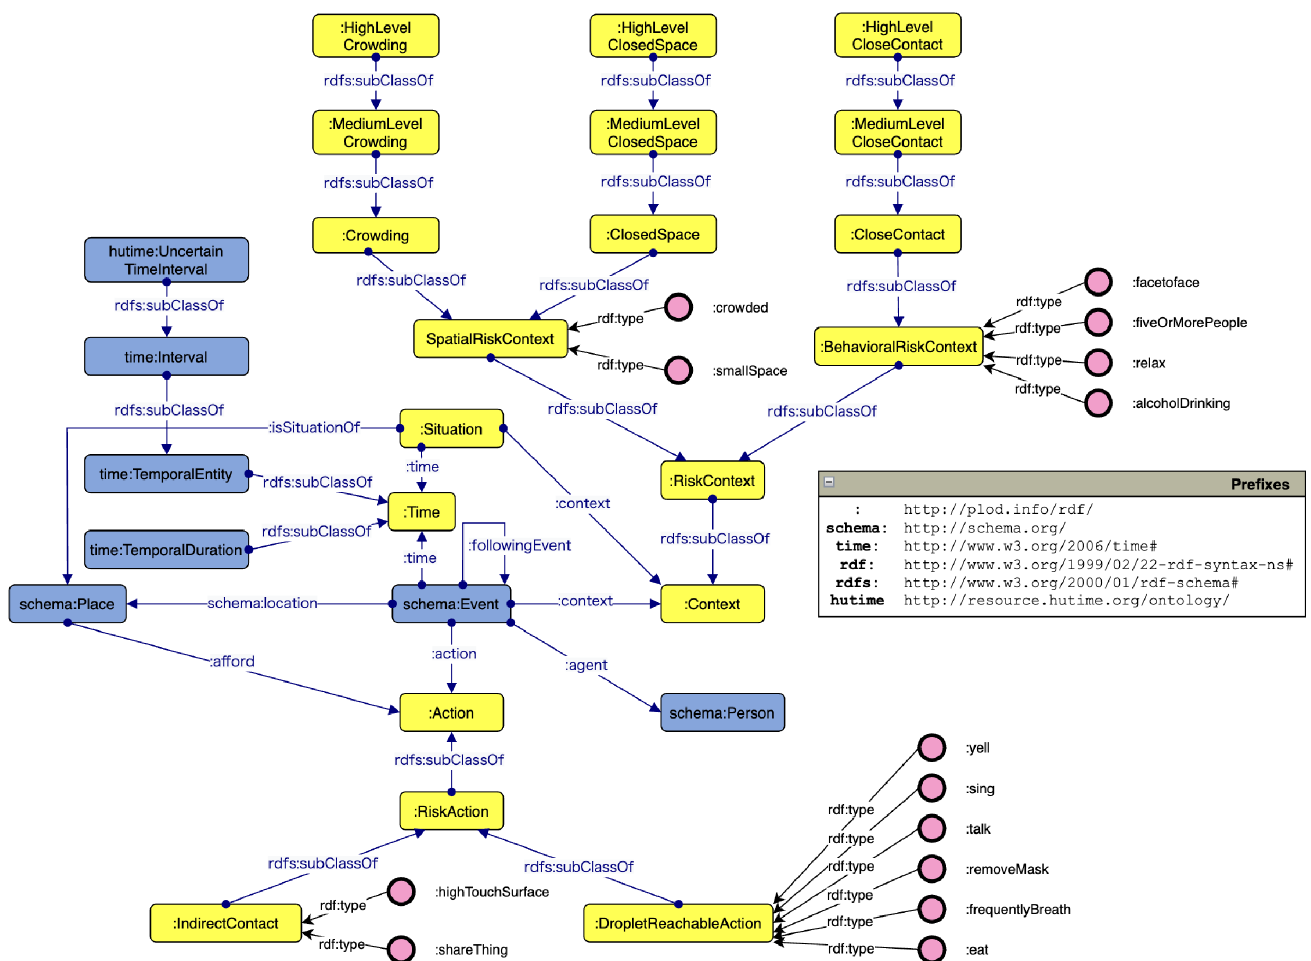
Fig 2. CIRO class relationship diagram. Yellow boxes are newly created in this paper, and blue boxes are reused from existing ontologies.